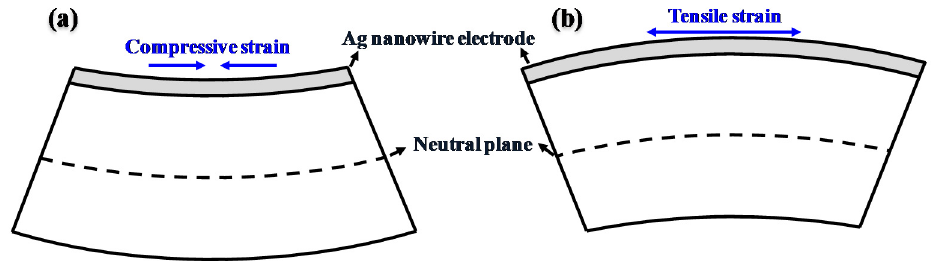
Figure 9. Schematic illustration of stress type depending on the position of silver nanowires on flexible substrates: ( a ) compressive strain and ( b ) tensile strain. Reproduced with permission from ref. [43]. Copyright 2016, Elsevier.